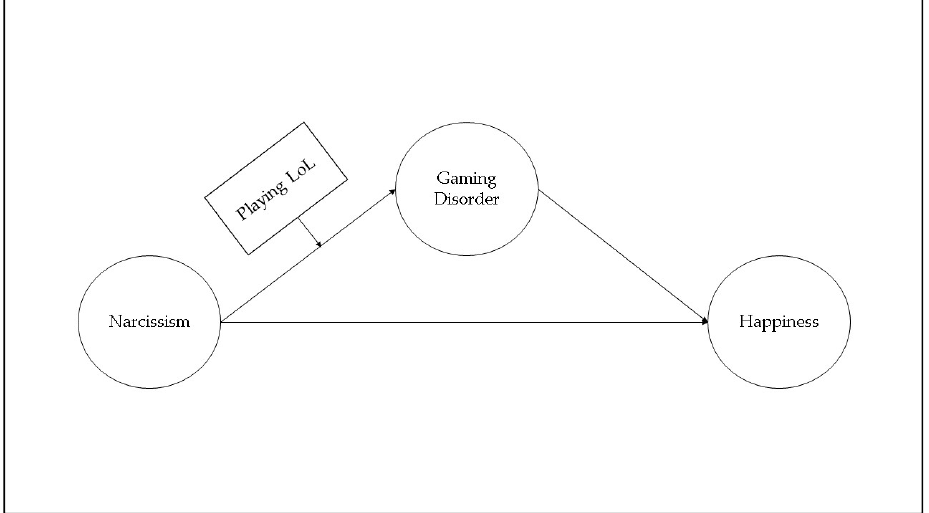
Figure 1. Conceptual diagram of research model (Model 7).